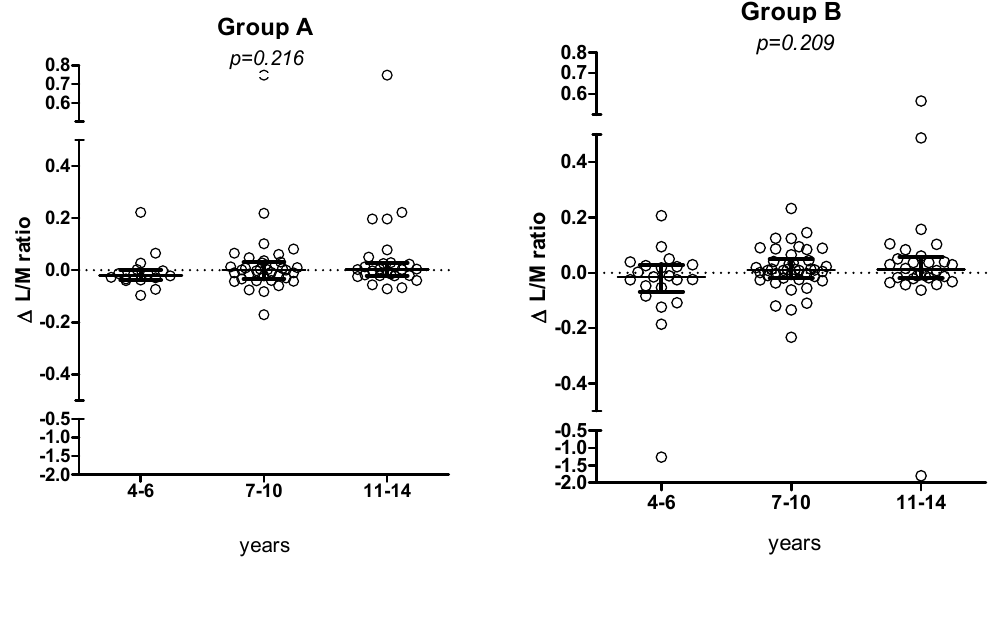
Figure 6. Changes in L/M values (median, IQR) according to the 3 age classes, in groups A and B,